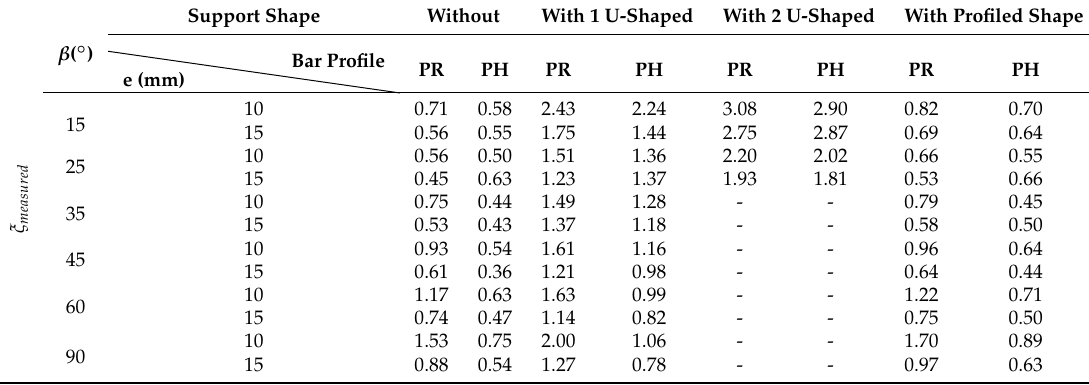
Table A2. Measured head loss coefficient ( ξ measured ) with (1 or 2) the U-shaped or profiled shape support or without support as a function of the bar shape (PR or PH), the bar spacing (e), and the angle of inclination ( β